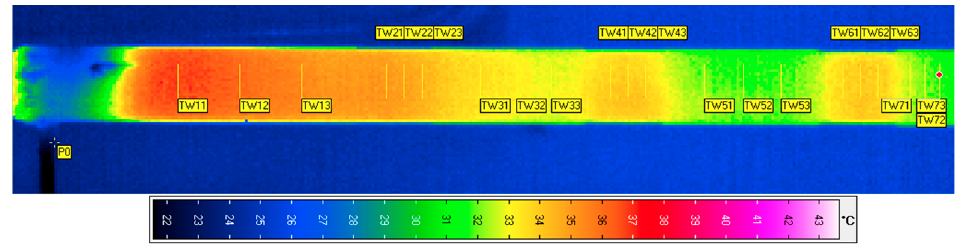
Figure 5. Single thermogram with marked measurement areas. The remaining area was at standard pipe wall thickness.